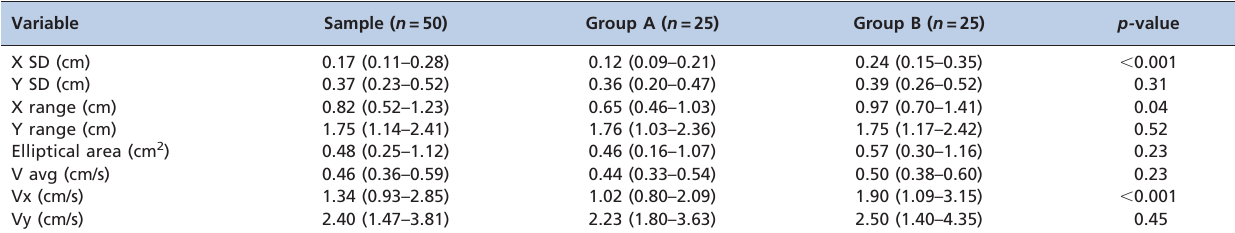
Table 2 - Stabilometric values of the studied sample performed under an open eye, open base condition. Variable Sample ( n =50) Group A ( n =25) Group B ( n =25) p- value X SD